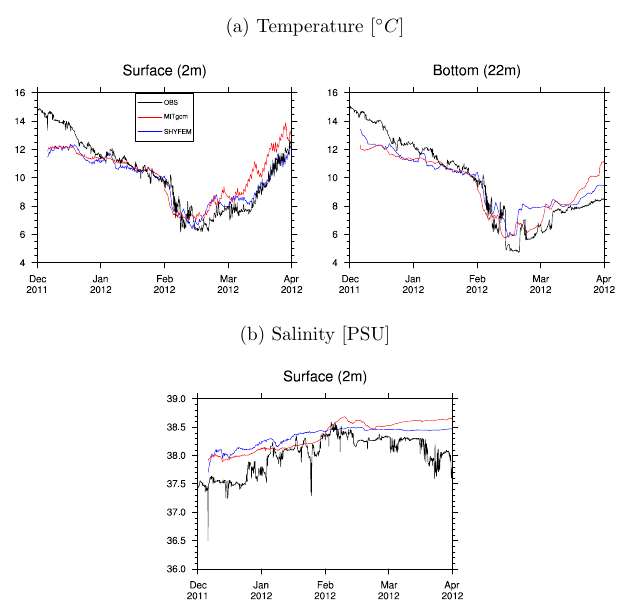
Figure 3. Time series of (a) surface (left panel) and bottom (right panel) temperature and (b) surface salinity for SHYFEM (blue), MITgcm (red) and the Vida buoy observations